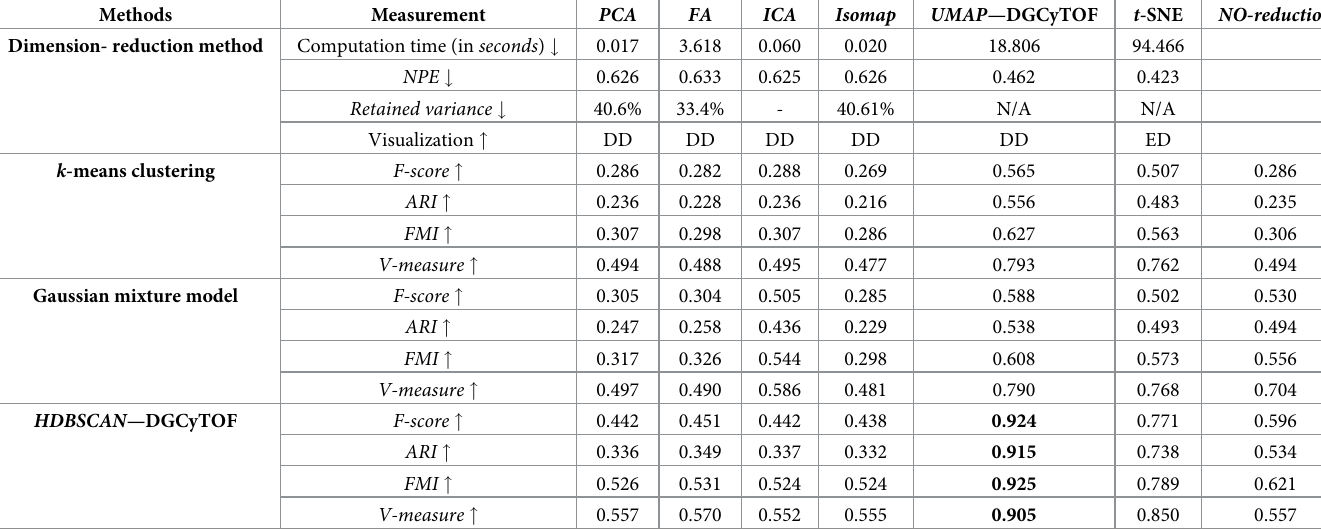
Table 4. Comparison of machine-learning methods by different measurements for CyTOF Dataset 1 (13 biomarkers, 24 labeled cell types).